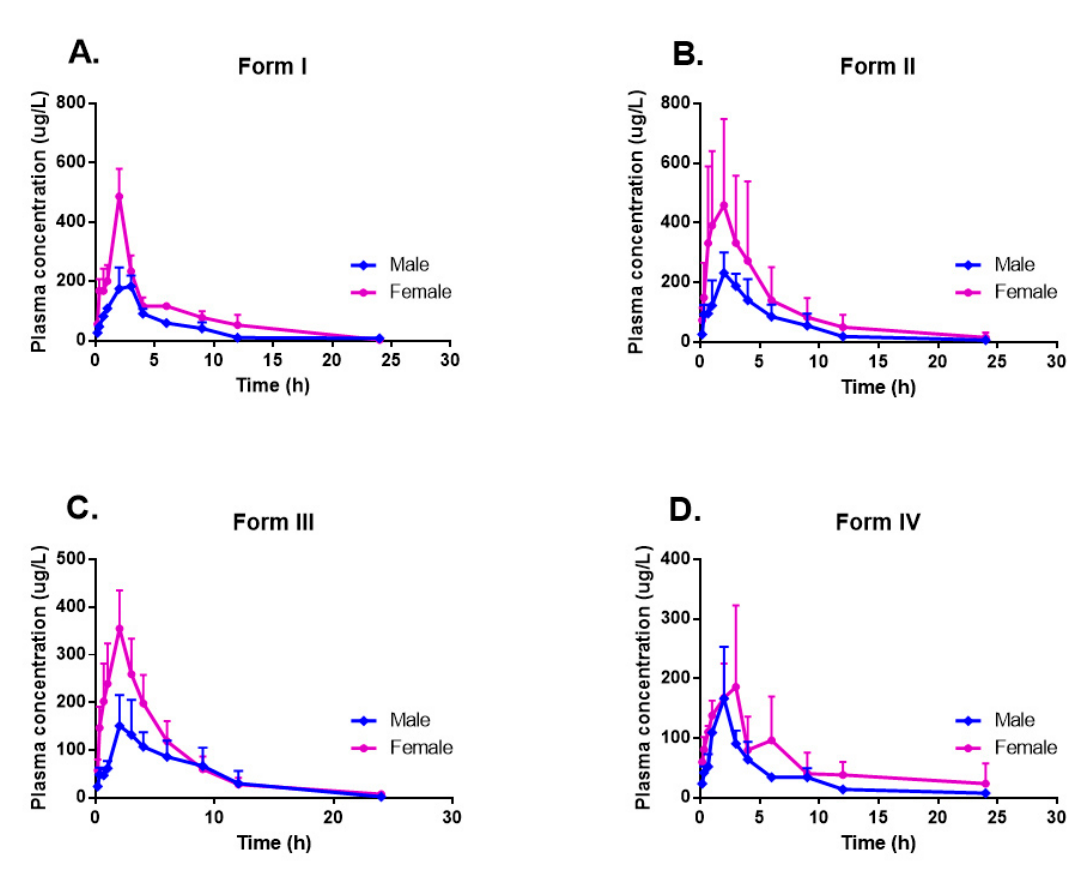
Figure 3. Plasma concentration-time profiles in sex groups after oral administration of the four forms of CK at a dose of 20 mg/kg in rats: ( A ) form I; ( B ) form II; ( C ) form III; and ( D ) form IV. Each point represents mean ± S.D. ( n = 3).